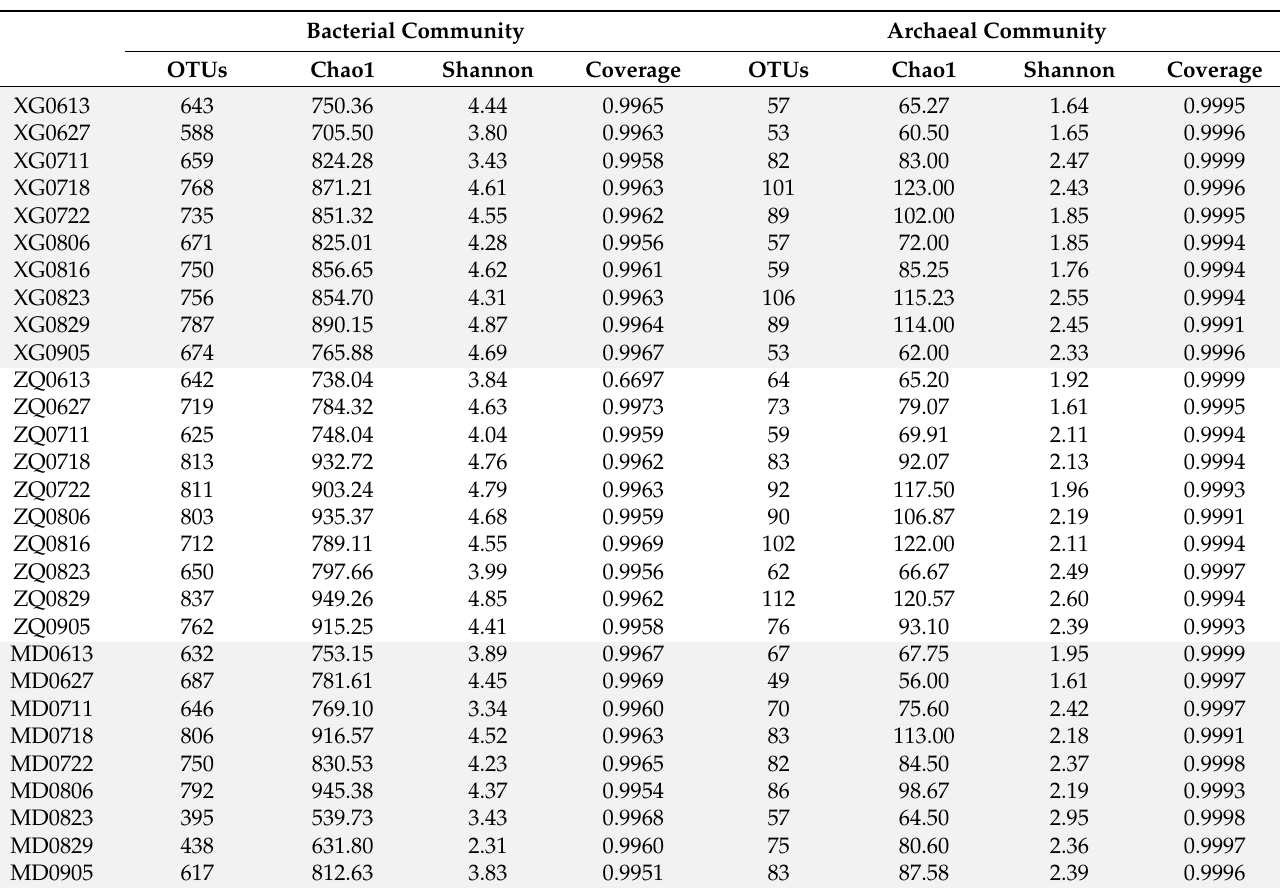
Table 3. Total OTUs, Chao1 index, Shannon index and Good’s coverage of bacterial and archaeal communities during the green